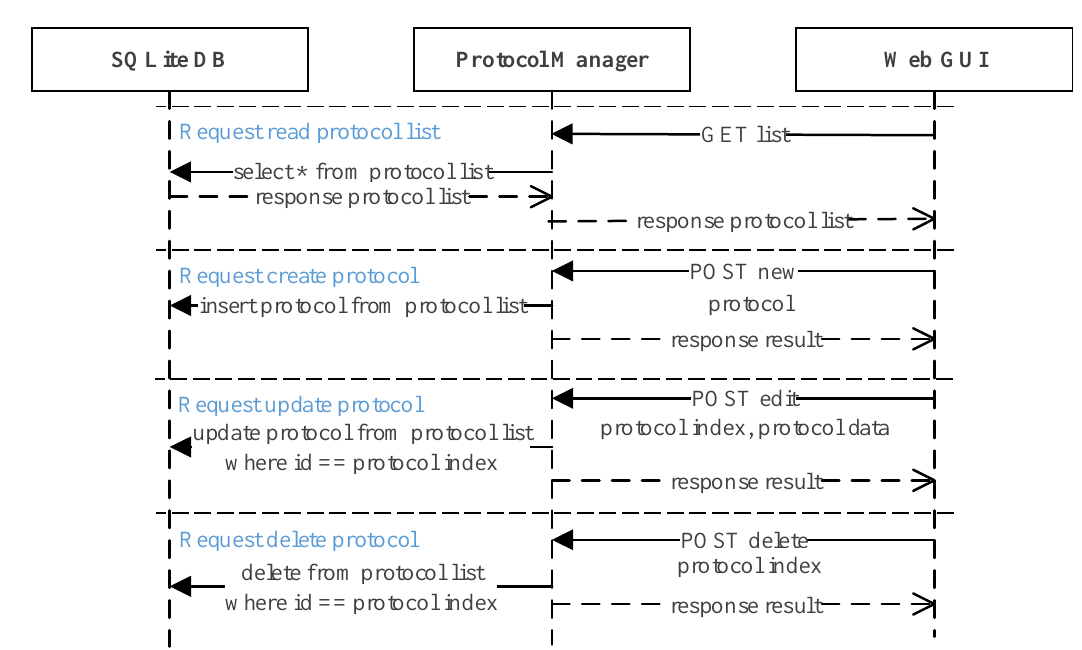
Figure 8. Protocol manager interaction scenario. Protocols can be read, created, updated, and deleted by sending a simple request from the web GUI to the protocol manager.